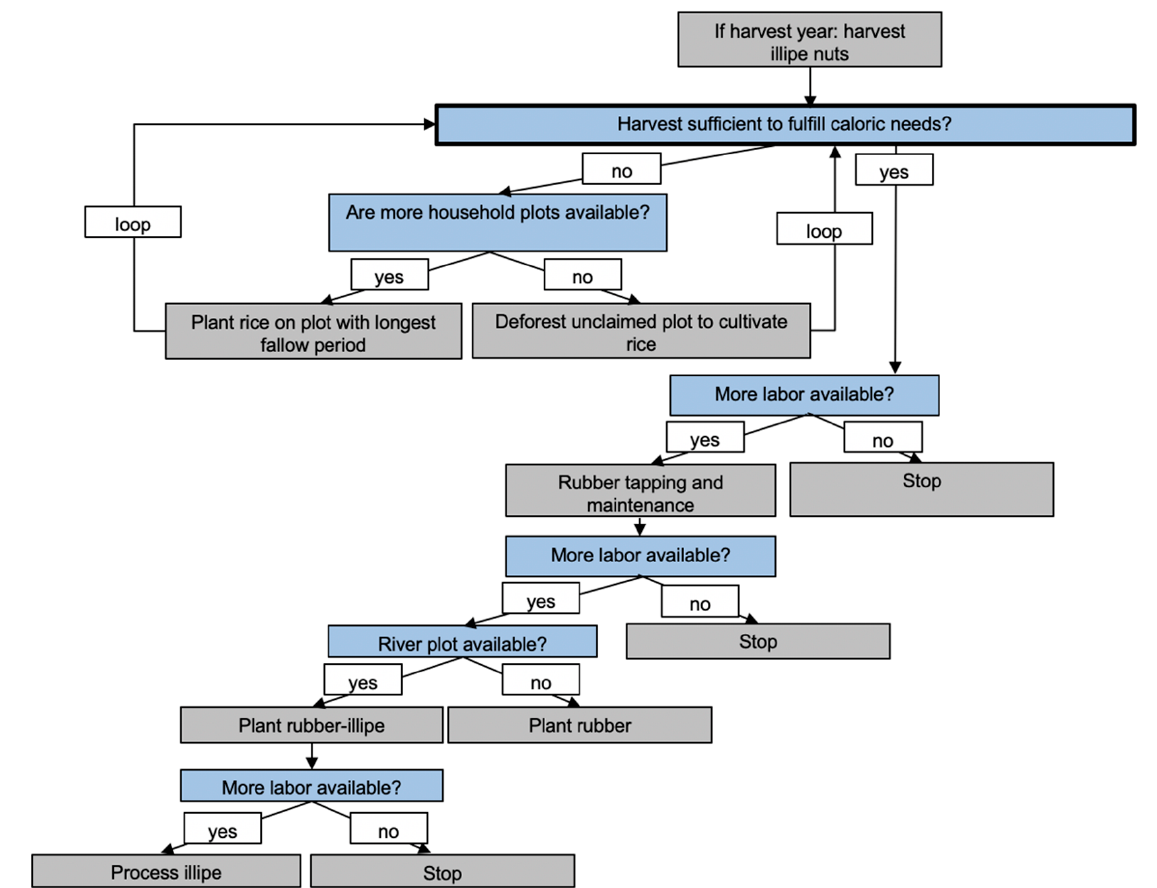
Figure 4. Model description: livelihood decision tree (IRA scenario).